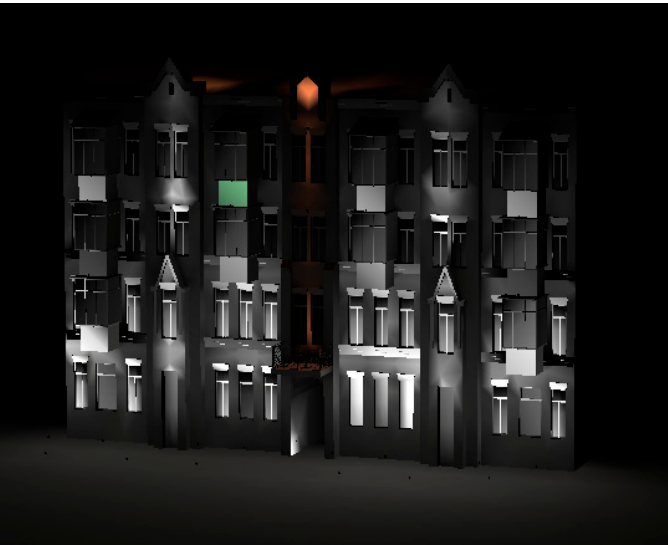
Figure 28. Fast communication of impressionism based on Monet’s painting “Impression”—Scene 3. Designs 2021 , 5 , x FOR PEER REVIEW